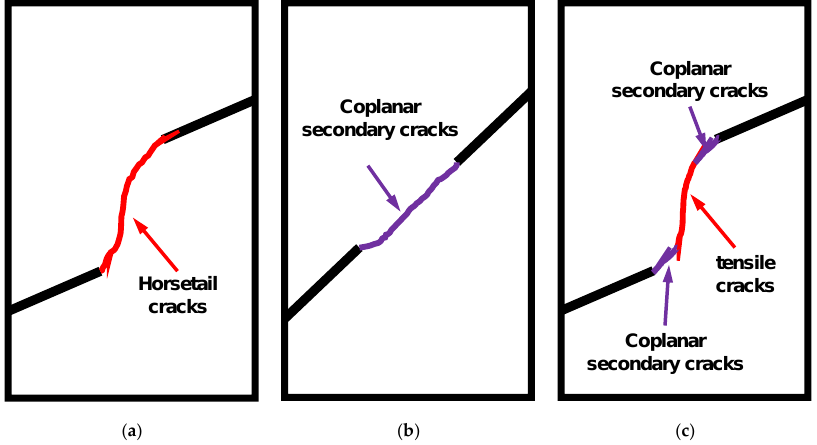
Figure 12. Three modes of crack coalescence in the rock bridge region. ( a ) Tensile crack coalescence, ( b ) mixed tensile–shear crack coalescence, and ( c ) shear crack coalescence.